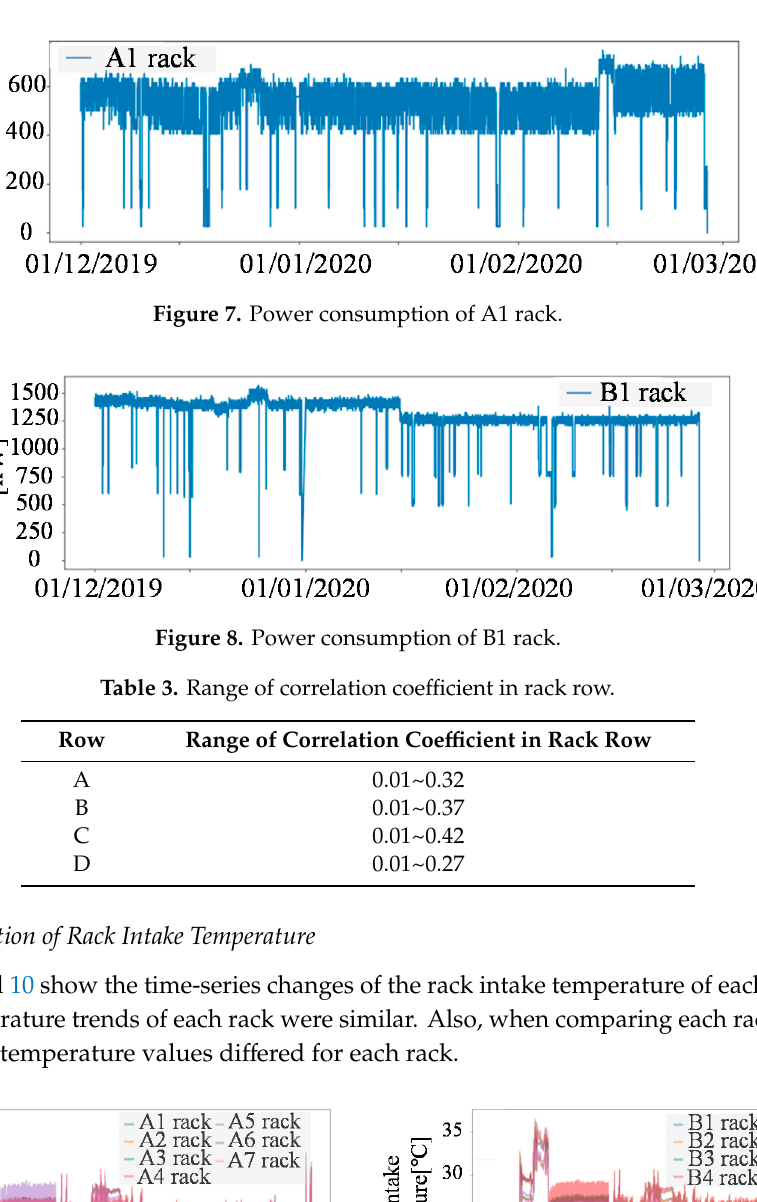
Figure 10. Time-series change of rack intake temperature in each rack row. ( a ) Rack intake temperature in C rack row. ( b ) Rack intake temperature in D rack row. Figure 11. Time-series changes of rack intake temperature classified as above or below 24 °C. (line: average value, over line: mean + standard deviation (SD), under line: mean − SD). 4. Construction of Prediction Model 4.1. Objective of Prediction and Operation Conditions As the objective variables in this study, we used the time-series changes of the rack intake temperature after the CRAC was stopped. We also examined two different operation conditions: one where the CRAC suddenly stopped while only one CRAC was operating and the other where one CRAC suddenly stopped while two CRACs were operating. The prediction interval was set to one minute, and the model predicted from one minute after the CRAC was stopped to the restart of the CRAC. From the basic aggregation of the rack intake temperature, we grasped that the rising gradient of rack intake temperature depends on the rack intake temperature at the time of stopping. As a result, when predicting the time-series changes in the rack intake air temperature after a shutdown, the prediction accuracy may be poor immediately after the CRAC is stopped. Therefore, the objective